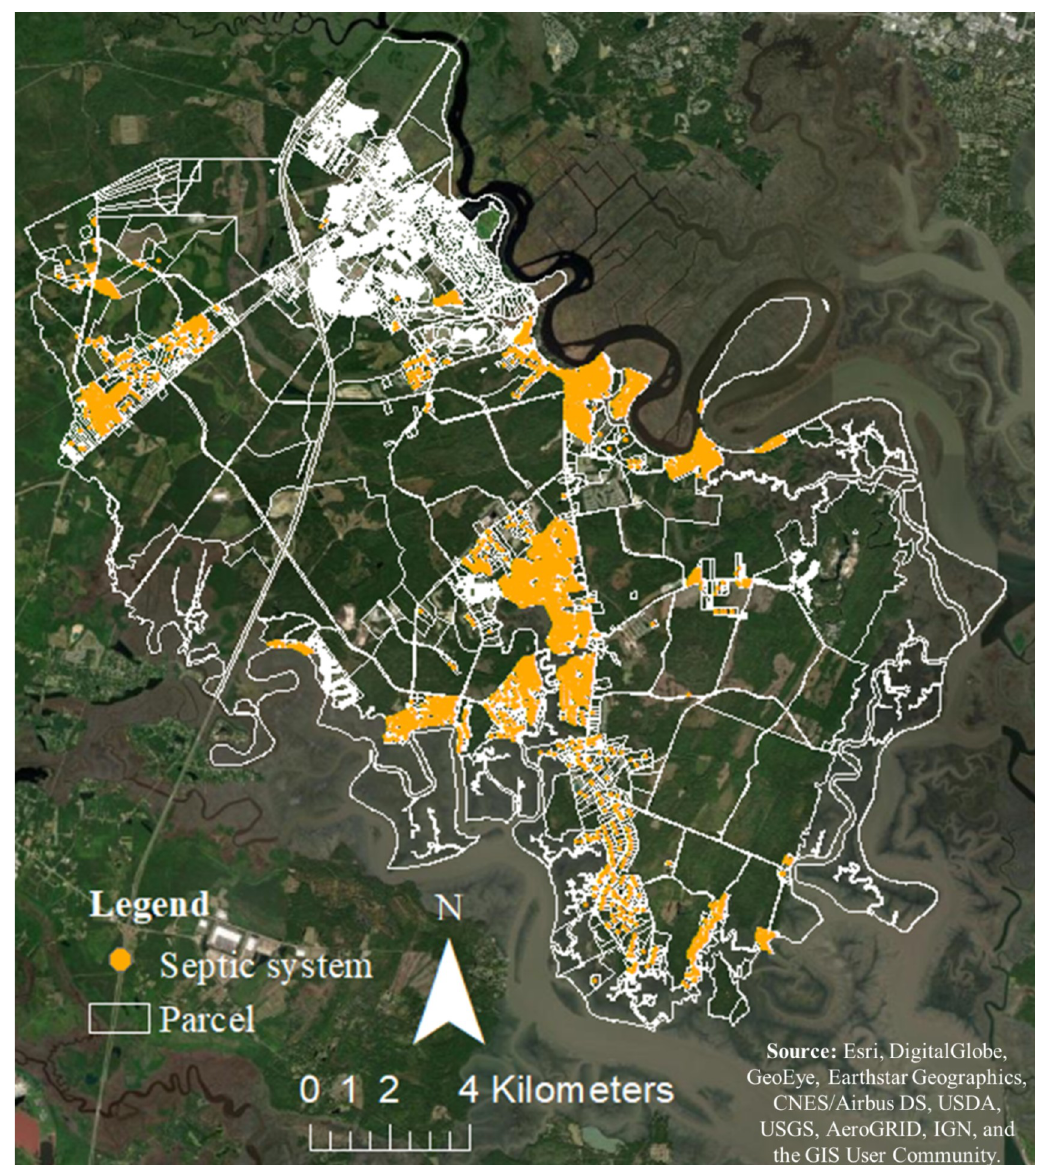
Fig 4. Visual distribution of septic system point features with the available inspection report and property report (n = 3343) within each parcel in the southern part of Bryan County, Georgia [33].